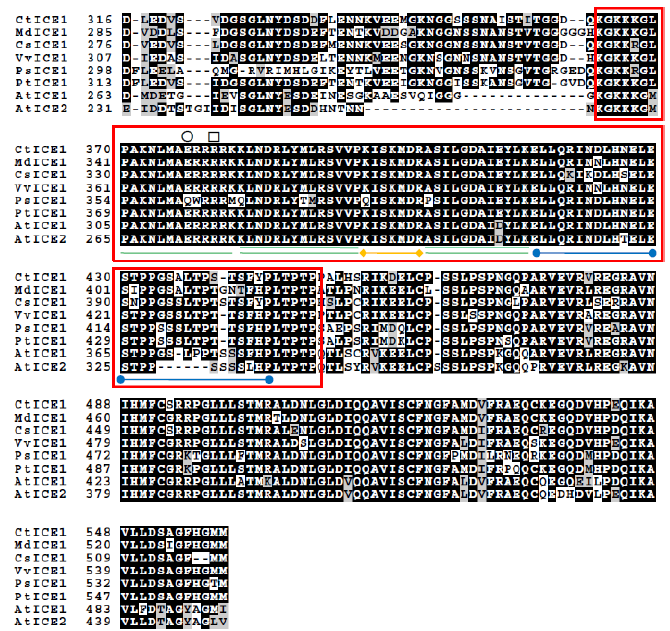
Figure 1. Multiple alignments of the deduced amino acid sequence of CsICE1 and those of other plant species. Short names and accession numbers are as follows: Camellia sinensis (CsICE1, ACT90640.2), Citrius trifoliata (CtICE1, AIZ78178.1), Populus trichocarpa (PtICE1, ABN58427), Vitis vinifera (VvICE1, XP_002284528.1), Populus suaveolens (PsICE1, ABF48720), Arabidopsis thaliana (AtICE1, AAP14668; AtICE2, BAC42644), Malus domestica (MdICE1, ABS50251). The multiple alignment was performed with Clustal X using the default parameters. Identical and similar residues are shown in black and grey backgrounds, respectively. The bHLH domain and zipper region (ZIP) are indicated by the red cylinder, and the square and circle indicate glutamate and arginine, respectively. The single green line below the sequence indicates the basic region, while double green lines represent the helix regions, which are connected by a loop, indicated by the yellow line. The blue line shows the leucine-zipper region. Agriculture 2020 , 10 , x FOR PEER REVIEW